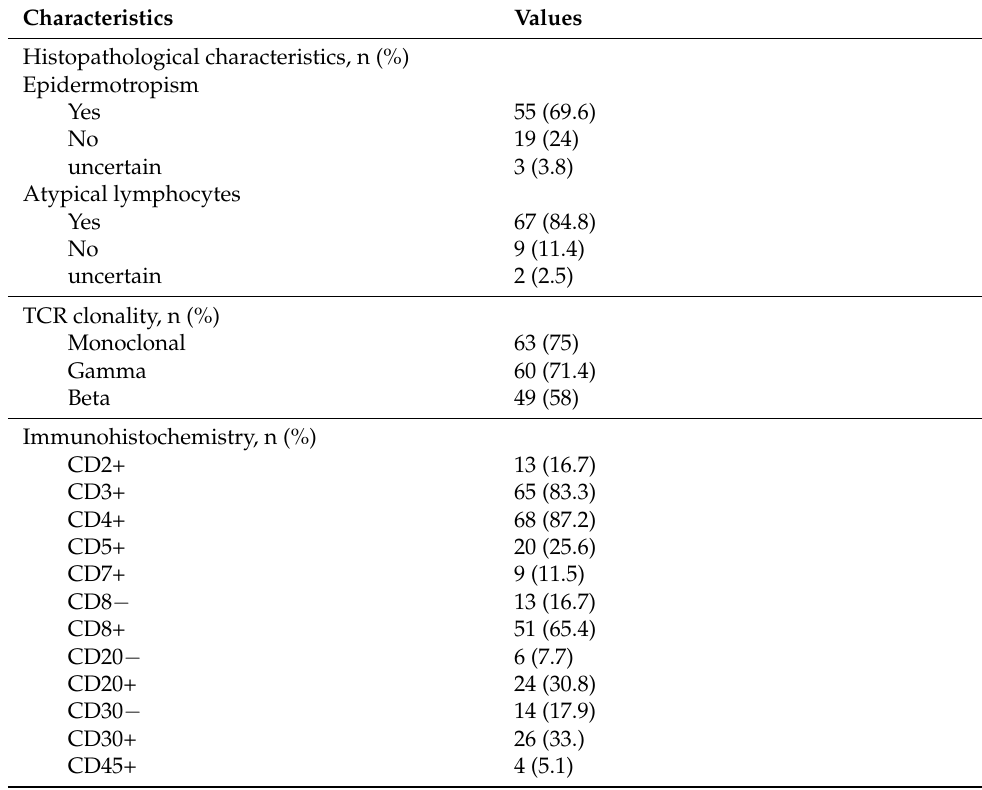
Table 3. Summary of histopathological and immunohistochemical variables of 84 patients with mycosis